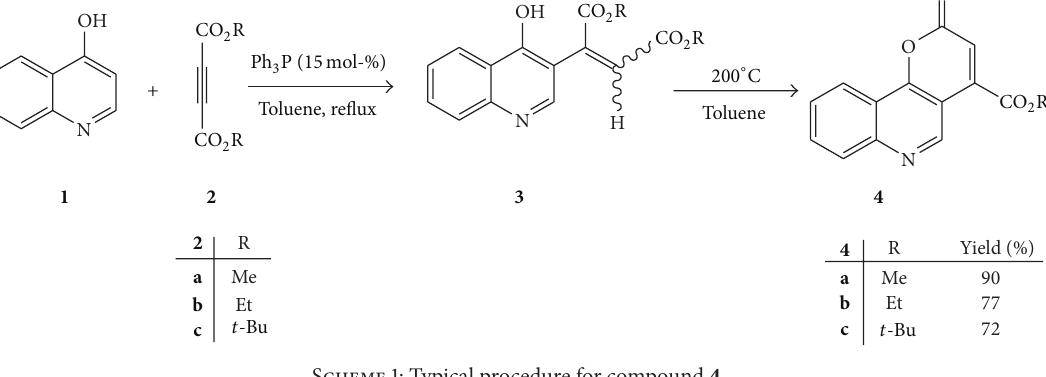
Scheme 1: Typical procedure for compound 4 .